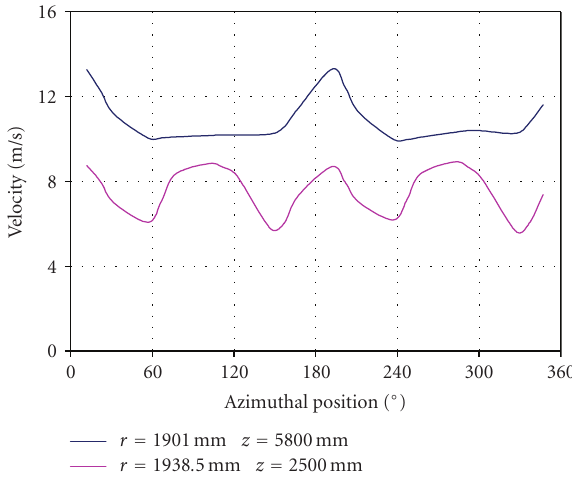
Figure 7: Azimuthal velocity profile in the downcomer at two di ff erent horizontal positions.